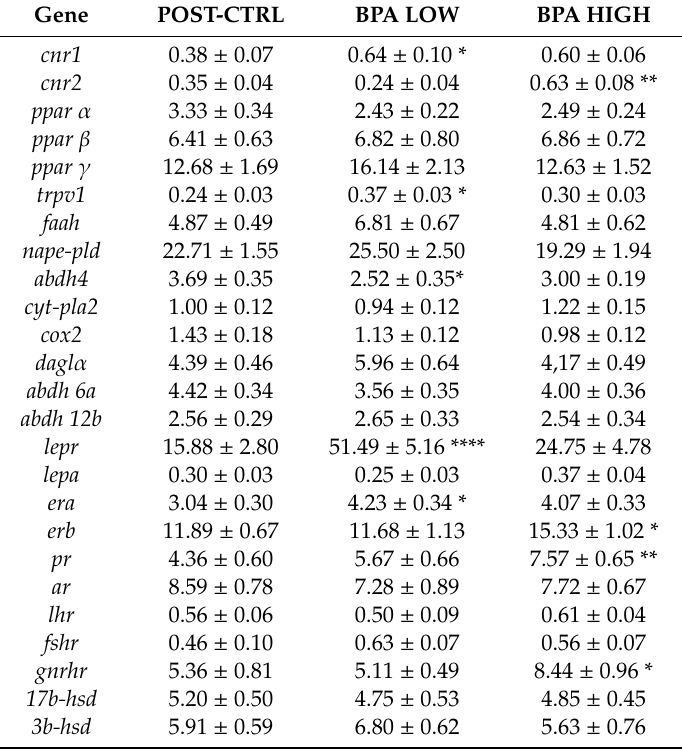
progesterone receptor, ar : androgen receptor, lhr : luteinizing hormone receptor, fshr : follicle-stimulating hormone receptor, gnrhr : gonadotropin-releasing hormone receptor, 17 β -hsd : 17 β -hydroxysteroid dehydrogenase, 3 β -hsd : 3 β -hydroxysteroid dehydrogenase. Gene